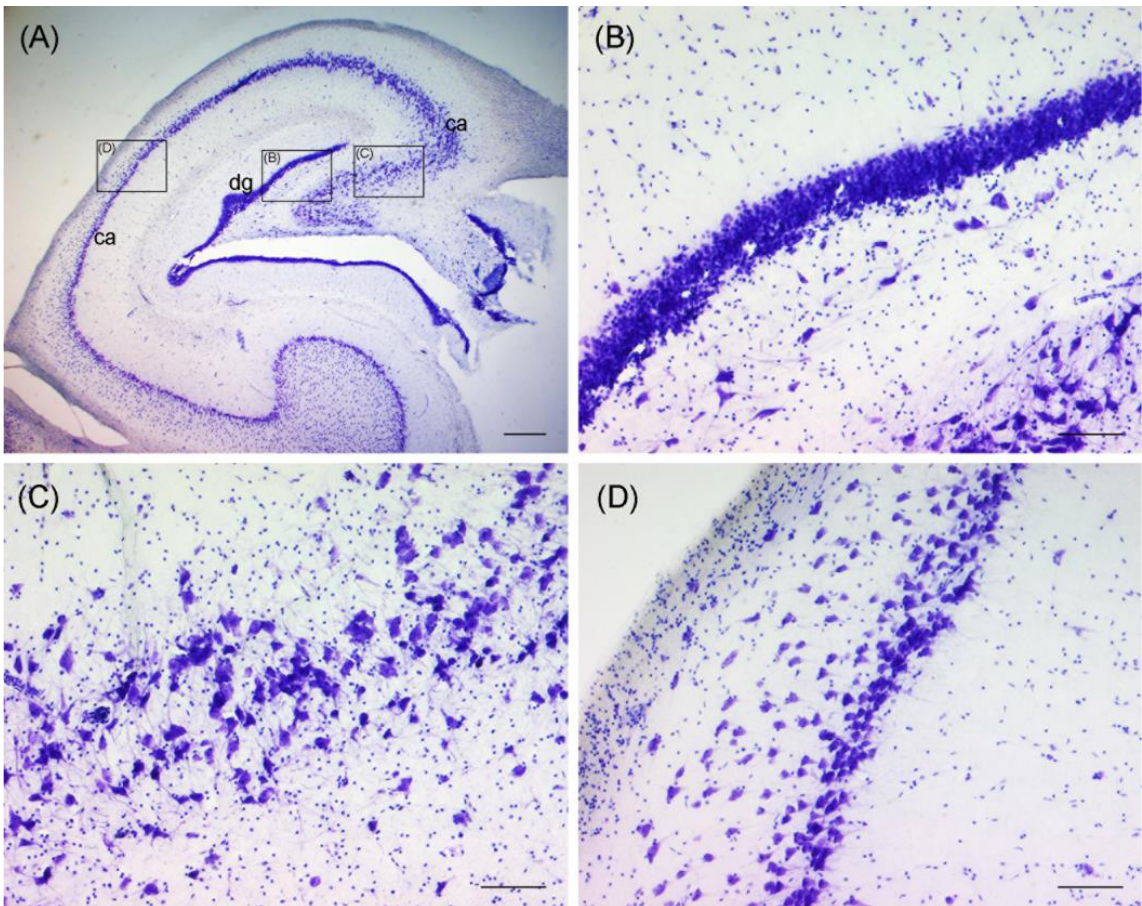
Figure 3. Thionine staining of the hippocampal formation of an otter, coronal section, showing the dentate gyrus (dg) and the cornu ammonis (ca) ( A ). Black rectangles indicate close-ups of ( B – D ).